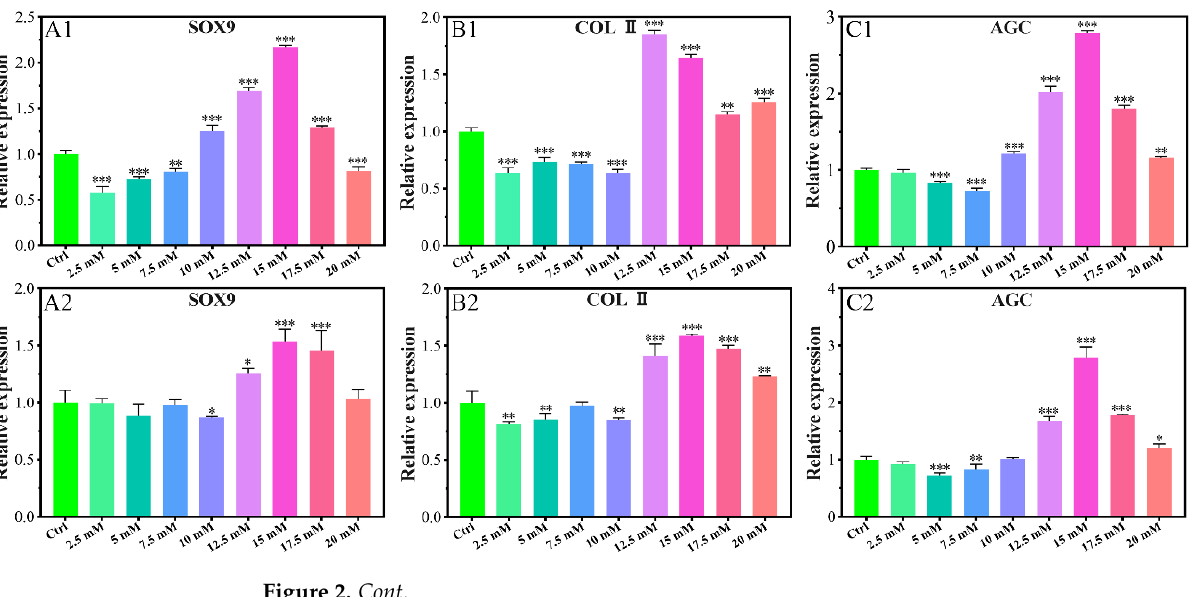
Figure 2. Effects of gene expression of chondrocytes cultured in different Mg 2+ concentrations on the 7th day ( A1 , B1 , C1 , D1 , E1 ) and the 14th day ( A2 , B2 , C2 , D2 , E2 ). All data are presented as fold change after normalization to GAPDH, and fold changes are shown as mean ± SD, * p < 0.05, ** p < 0.01, and *** p < 0.001. The expression of the collagen type II (COL II) gene was inhibited in the concentra- tion range of 2.5–10.0 mM on the 7th day (Figure 2B1), and that of 2.5–10.0 mM on the 14th day with a slight exception concentration of 7.5 mM (Figure 2B2). The gene expression promotion concentration range was 12.5–20.0 mM on the 7th day with the highest value for the concentration of 12.5 mM, which kept up to the 14th day with the highest expres- sion for that of 15.0 mM. The expression of the aggrecan (AGC) gene was also promoted in a similar range as that of SOX9, i.e., 10.0–20.0 mM on the 7th day (Figure 2C1), and 12.5–20.0 mM on the 14th day with the highest value for the concentration of 15.0 mM of Mg 2+ (Figure 2C2). The gene expression of collagen type X (COL X) was promoted only for the concen- tration of 7.5 mM and 10.0 mM on the 7th day (Figure 2D1) and the fourteenth day. 17.5 mM concentration of Mg also had a promoting effect on the 14th day (Figure 2D2). For all of the other concentrations of Mg 2+ at any time, the expression of COL X was inhibited or not changed according to the data. The expression of the collagen type I (COL I) gene was promoted in the concentration of Mg 2+ of 5.0–12.5 mM and 17.5–20.0 mM on the 7th day (Figure 2E1), and that range of